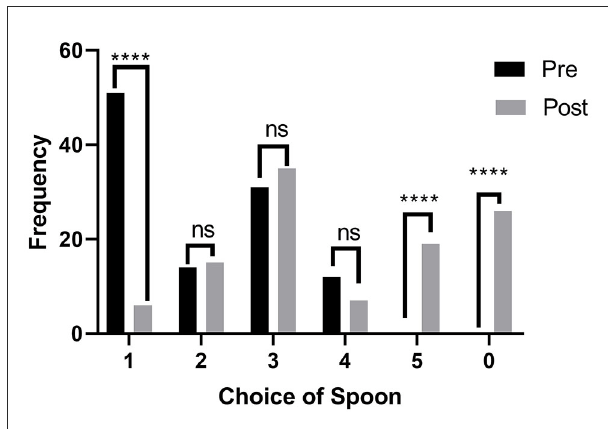
FIGURE3 Pre- and post-intervention selection of spoons from household spoons by respondents for oral liquid medicine administration. **** means very highly significant.